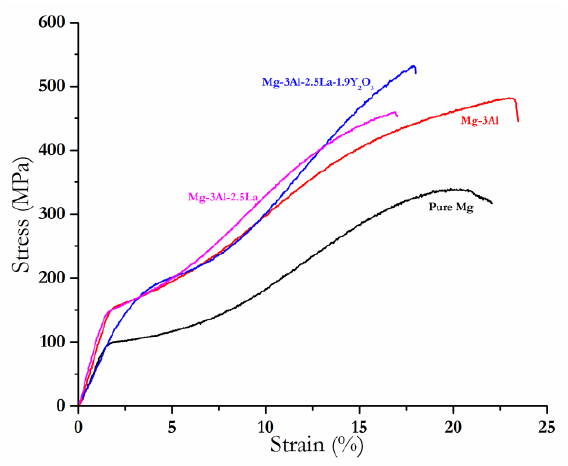
Figure 5. Stress-strain curves of extruded pure Mg, Mg–3Al, Mg–3Al–2.5La and Mg–3Al–2.5La–1.9 Y 2 O 3 alloys under compression loading.